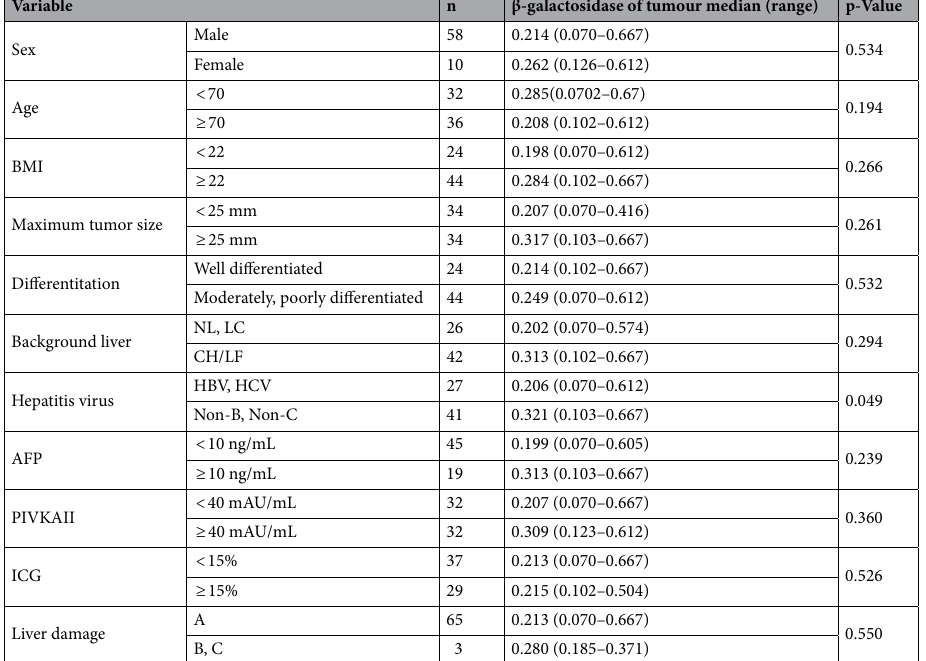
Table 1. Association between clinicopathological factors and β-galactosidase (β-Gal) activity in hepatocellular carcinoma (HCC) tumour tissues. β-Gal activity in HCC tumour tissues was analysed in relation to clinicopathological factors. β-Gal activity in the tumour tissue of patients not infected with hepatitis B virus (HBV) and hepatitis C virus (HCV) was significantly higher than that in the tumour tissue of patients infected with HBV and HCV. On analysing other clinicopathological factors (sex, age, BMI, background liver, AFP, PIVKAII, ICG, and grade of liver damage), β-Gal activity in the tumour tissues was not significantly different. A two-tailed Mann–Whitney U -test was used to analyse data. BMI; body mass index, NL; normal liver, CH; chronic hepatitis, LF; liver fibrosis, LC; liver cirrhosis, Non-B; patients not infected with HBV, Non-C; patients not infected with HCV, AFP; alpha-fetoprotein, PIVKAII; protein induced by vitamin K absence or antagonist-II, ICG; indocyanine green. Liver damage was defined based on the General Rules for the Clinical and Pathological Study of Primary Liver Cancer, Edition 6, Revised Version 35